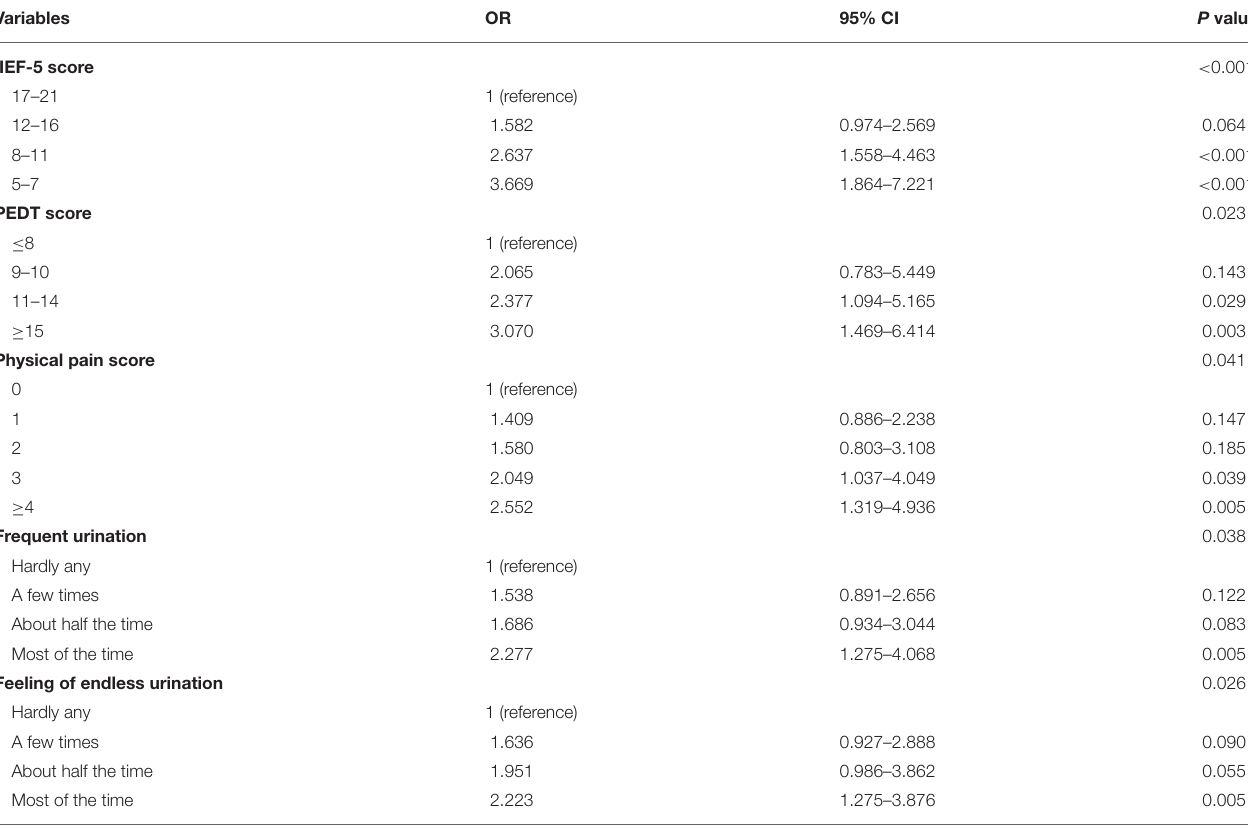
TABLE 2 | Multivariable logistic regression of predictors for screening major depression in patients with erectile dysfunction (training cohort). Variables OR